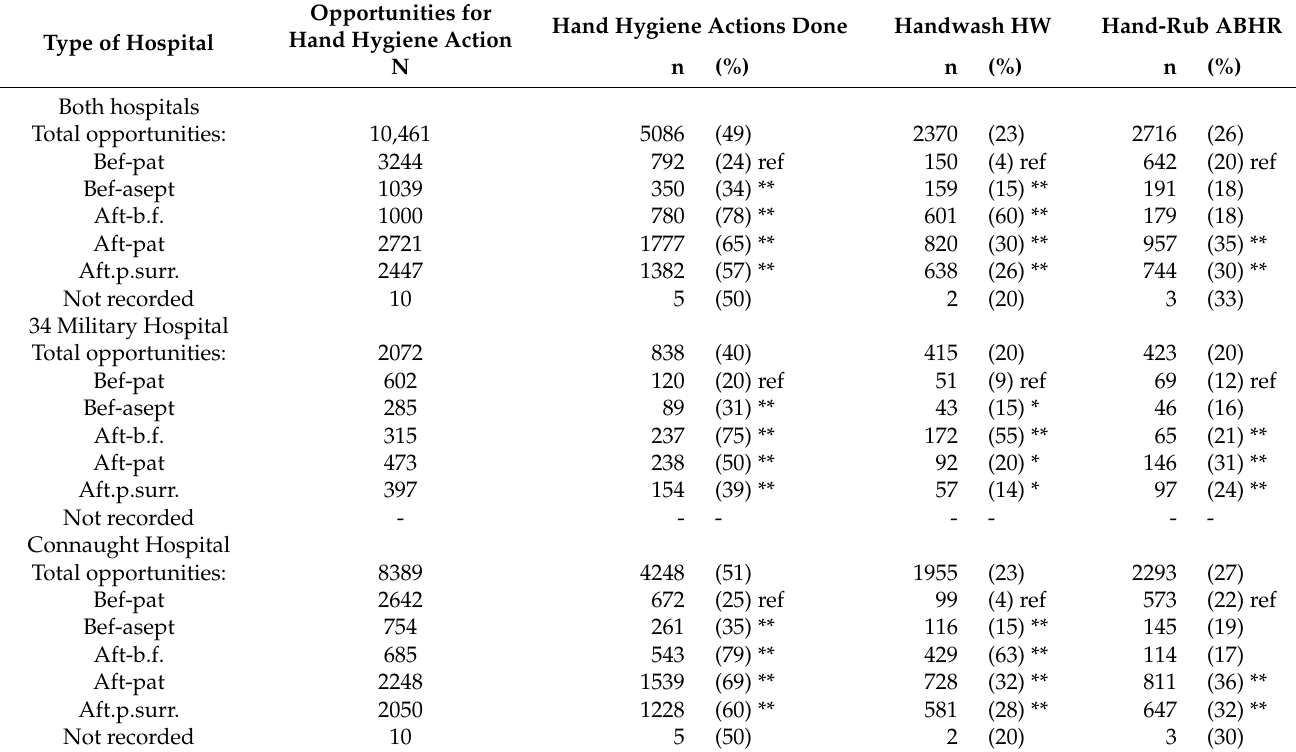
Table 1. Hand hygiene compliance between and within the two tertiary hospitals in relation to the opportunity (moment) for a hand hygiene action and in relation to whether this was handwash or hand rub (ABHR) in Freetown, June–August